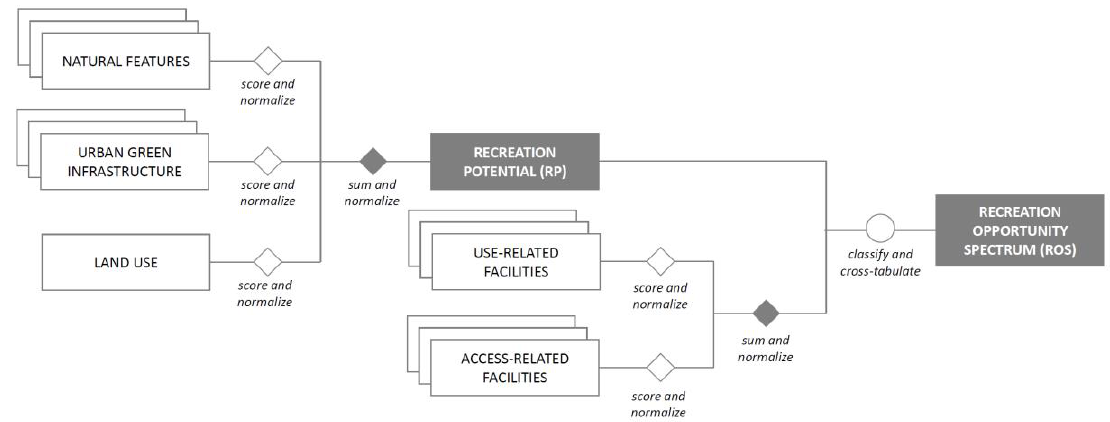
Figure 2. Flow chart of the adapted version of the ESTIMAP-recreation model applied to analyze nature-based recreation in Trento. Based on Ref. [51], modified after Ref. [46].